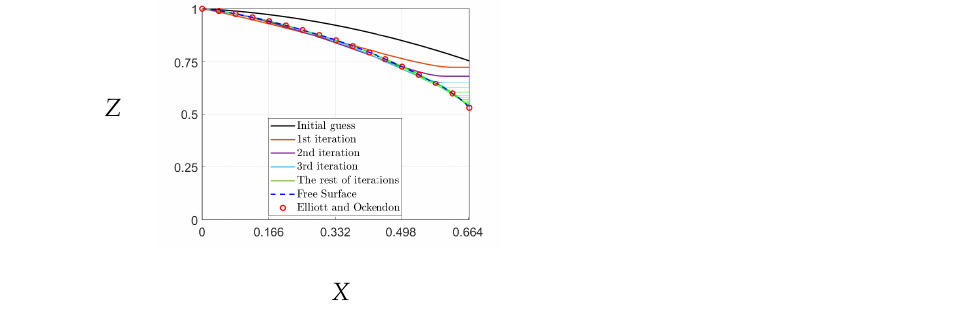
Figure A2. The iterations of free boundary to obtain the free surface and the comparison for the results reported in [8].